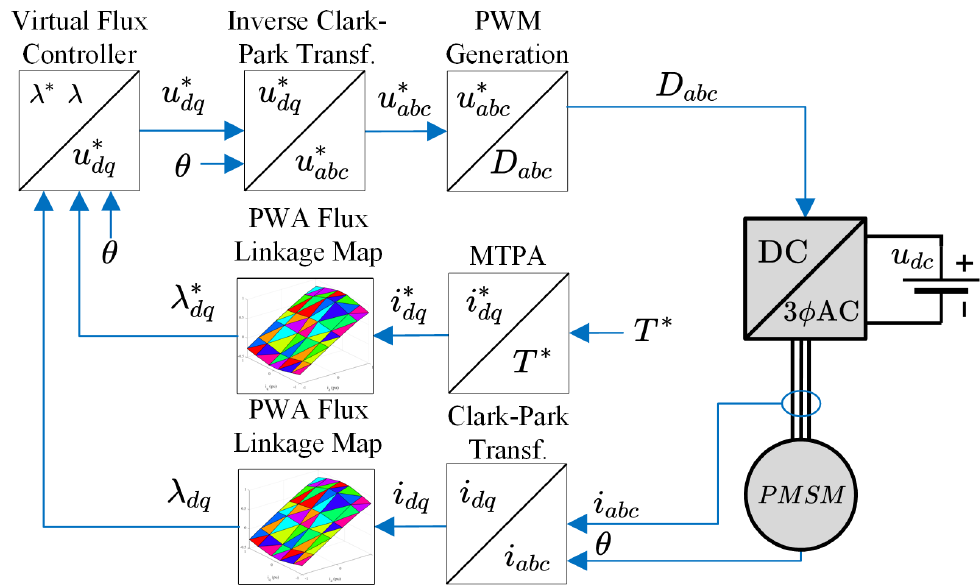
Figure 1. Example motor drive system (gray) and virtual flux controller architecture (white) demon- strating the use of the PWA MM flux linkage map.